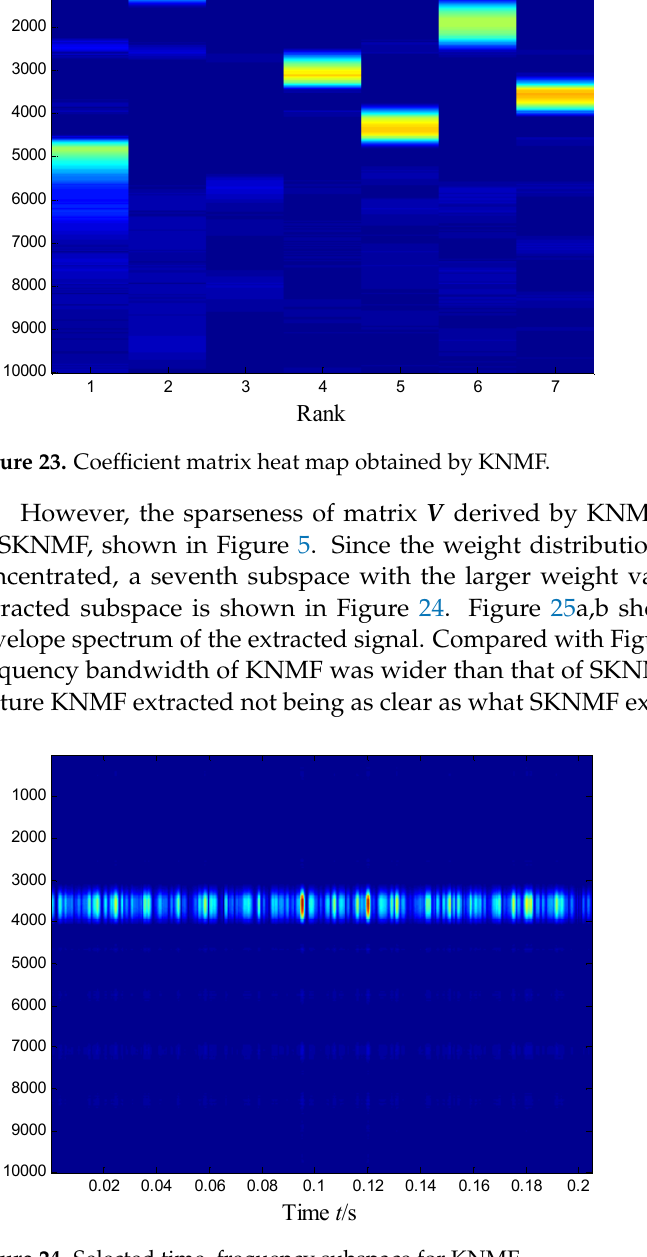
Figure 24. Selected time–frequency subspace for KNMF.